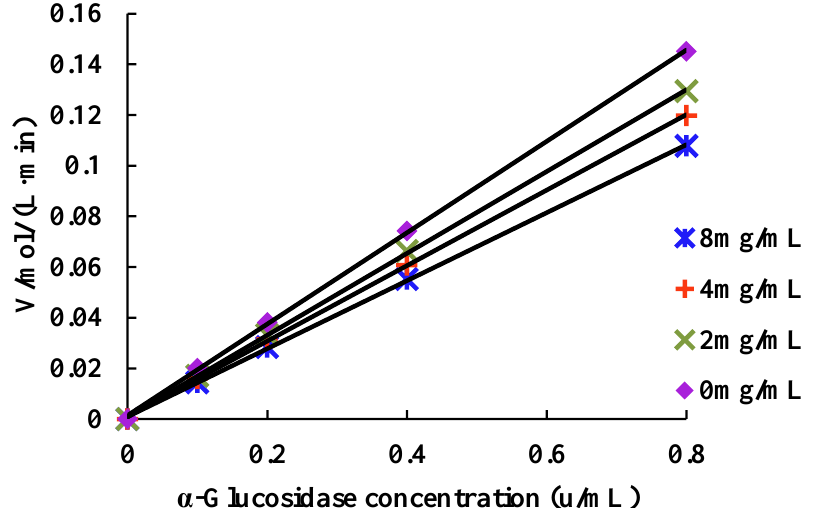
Figure 5. Linear fitting curve of the relationship between α -glucosidase and enzymatic reaction rate. To clarify the inhibition type of the MAP-2 inhibitor, an experimental model of PNPG with different concentrations of α -glucosidase was established in the presence of